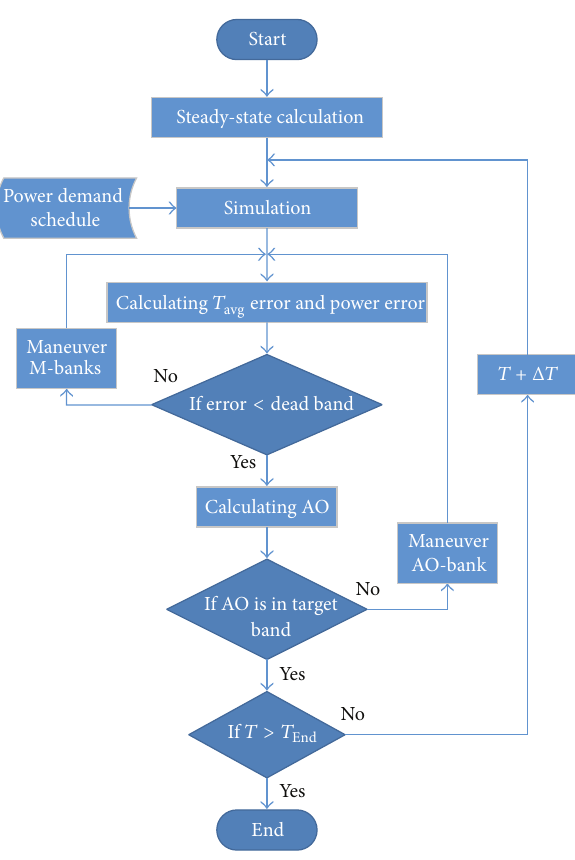
Figure 3: Simulation flow chart of RSFSP.